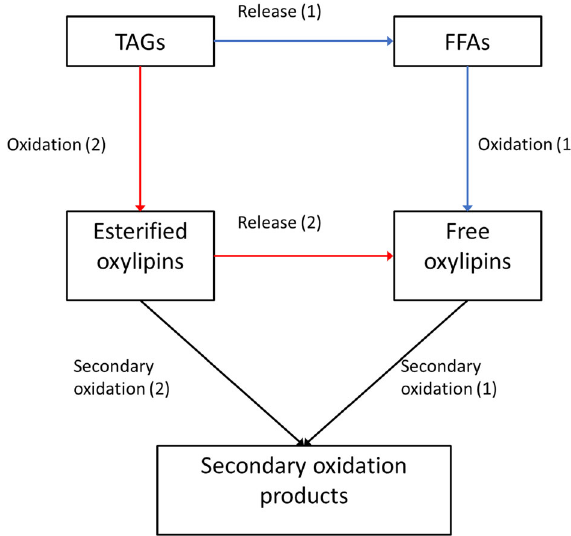
Fig. 1 Pathway depiction of how free and esteri fi ed oxylipins could form in heated oil. TAGs release FFAs which undergo oxidation to form free oxylipins (Pathway 1, blue arrow). Alter- natively, polyunsaturated fatty acids on TAGs can be directly oxidized to form esteri fi ed oxylipins (Pathway 2 in red). The oxidized oxylipins on TAGs can be released to generate free oxylipins (Pathway 2 in red). Secondary oxidation products can be generated by the breakdown of free or esteri fi ed oxylipins 32 . TAGs Triacylgly- cerols, FFAs free fatty acids.